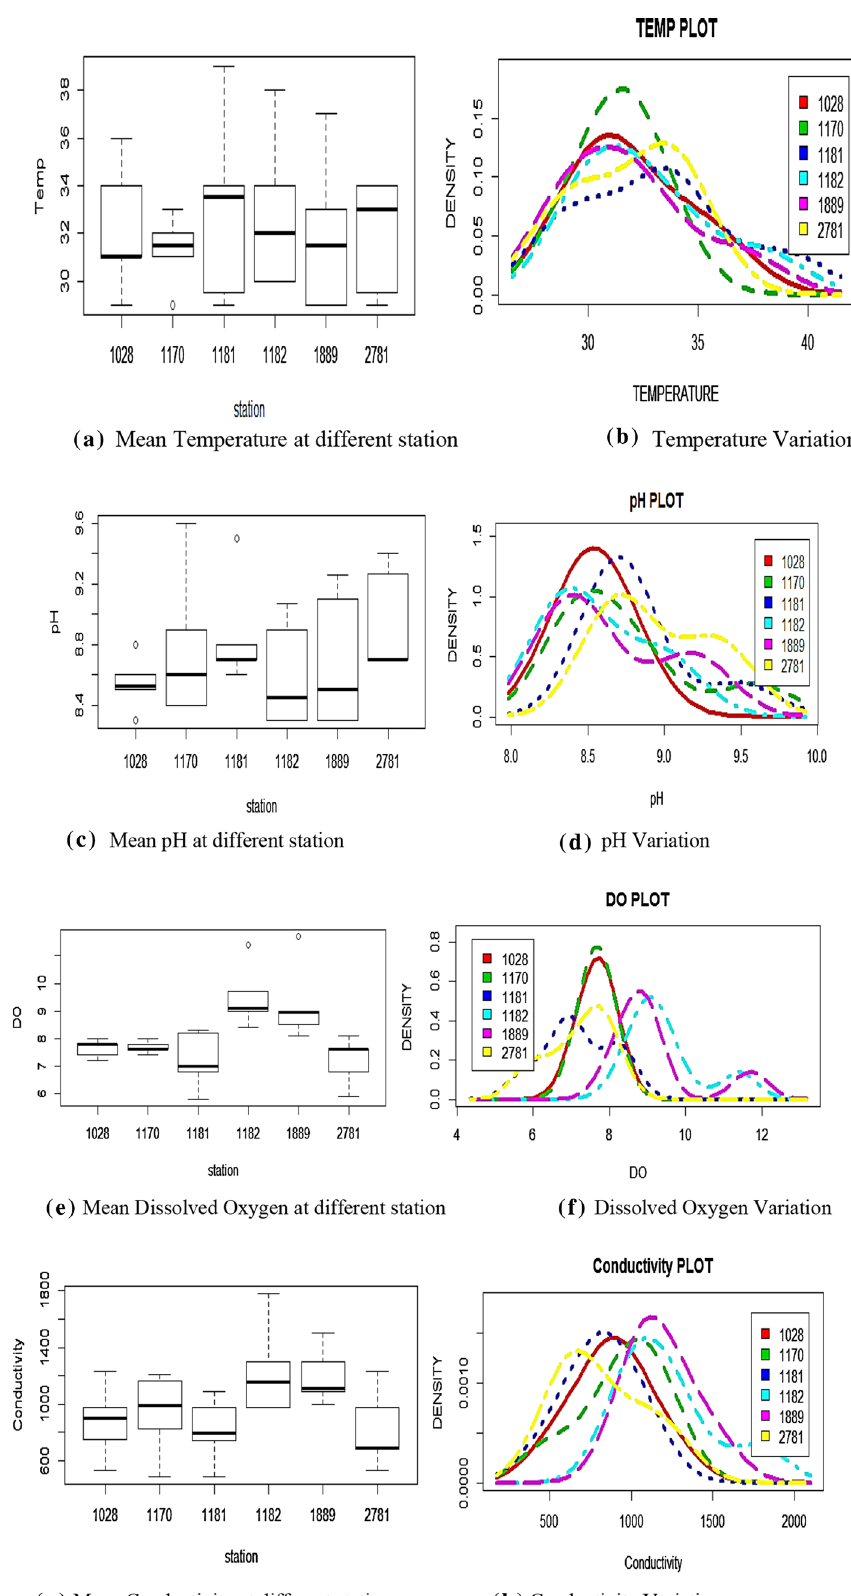
Fig. 4 a Mean temperature at different stations, b temperature variation, c mean pH at different stations, d pH variation, e mean dissolved oxygen at different stations, f dissolved oxygen variation, g mean conductivity at different stations, h conduc- tivity variation, i mean BOD at different stations, j BOD varia- tion, k mean nitrate at different stations, and l nitrate